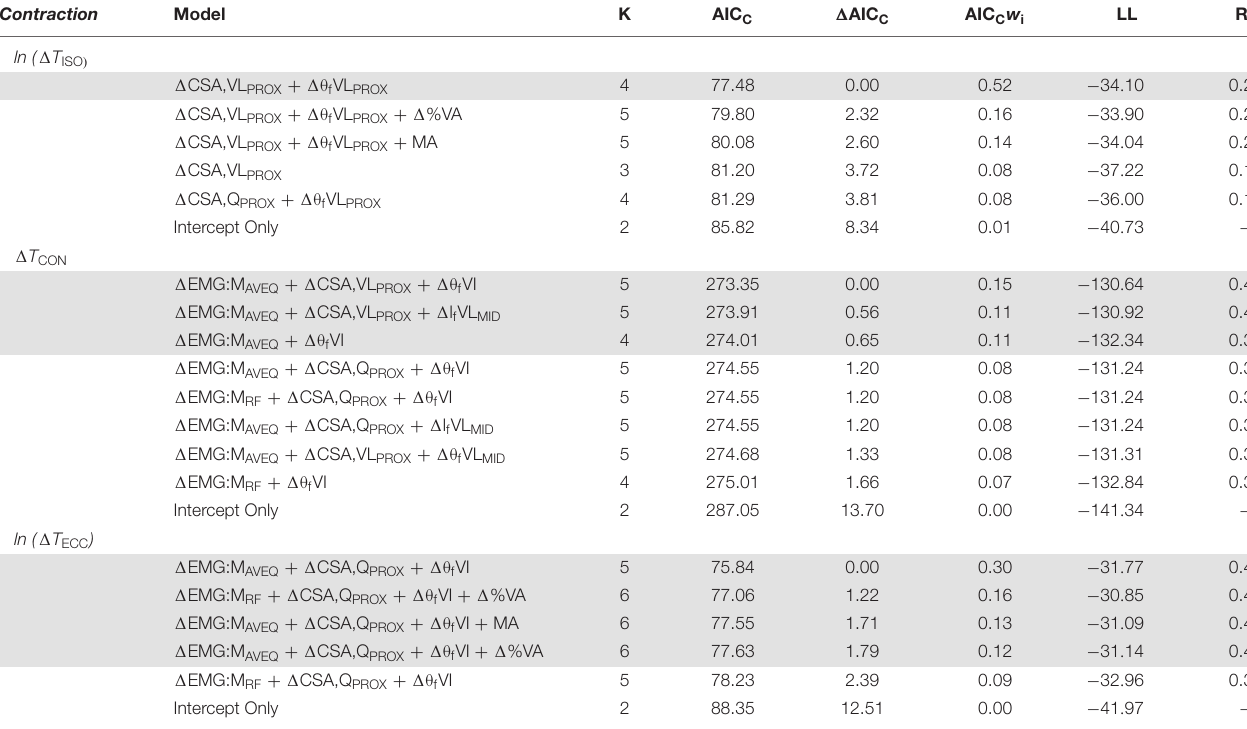
TABLE 4 | Akaikes’ Information Criterion (AIC) of model parameters for predicting the change in isometric, concentric and eccentric torque ( (cid:49) T) based on changes in the predictor variables ( (cid:49) ). Contraction Model K AIC C